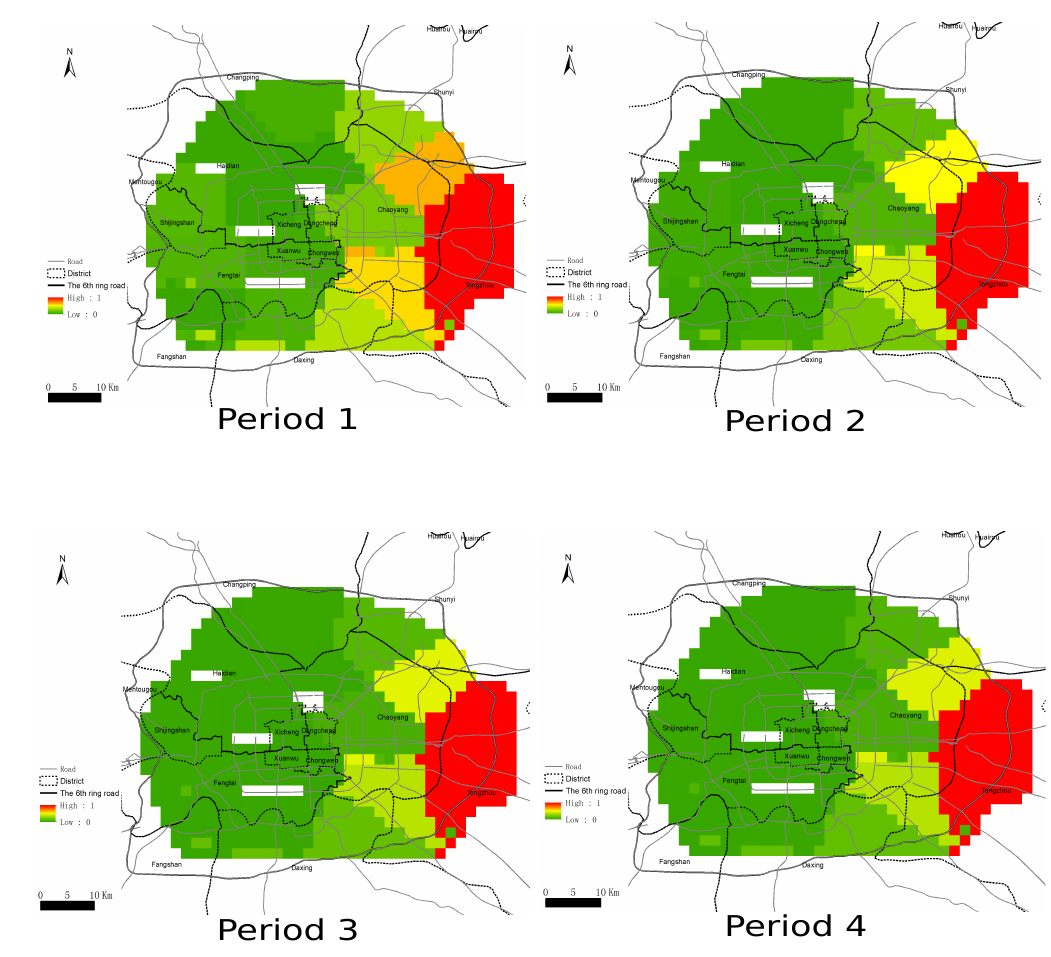
Figure 4. Evolution of the distributional density of market driving